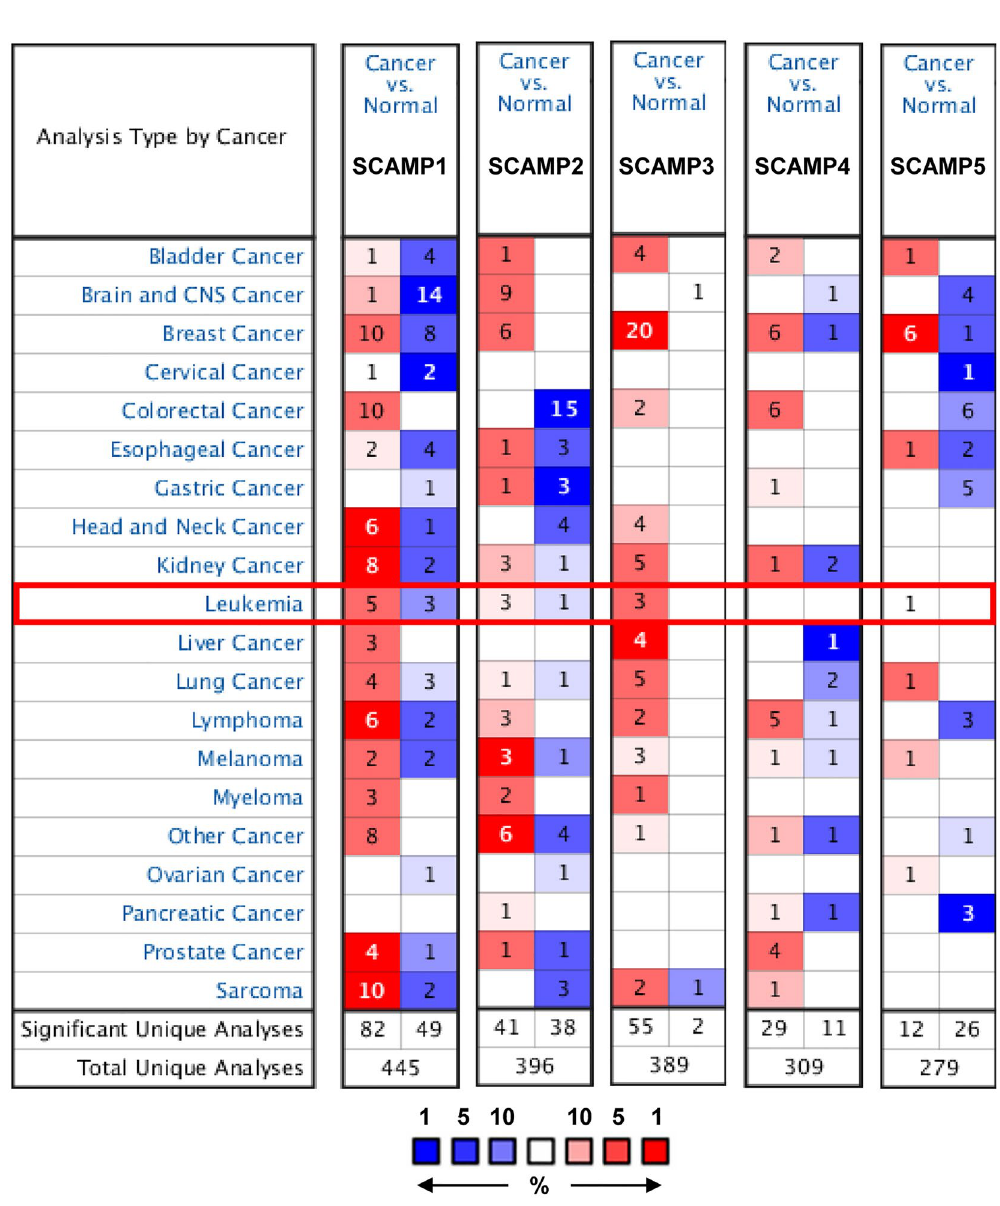
Figure 2. SCAMP mRNA expression in a range of cancers and leukemia (ONCOMINE database). Threshold values: P value = 0.001; fold-change =